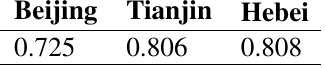
Table 8 Policy efficiency of government guide fund